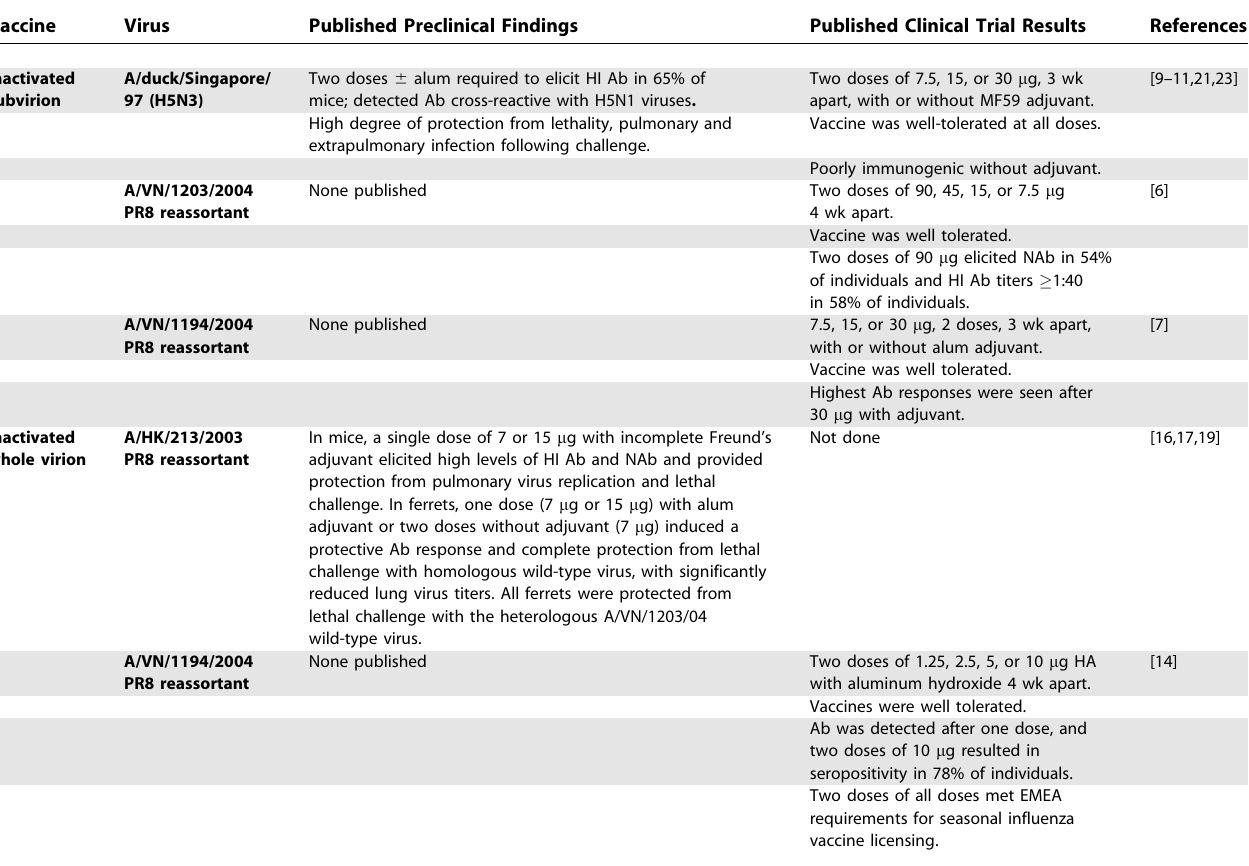
Table 2. Summary of Preclinical and Clinical Findings for Inactivated H5N1 Virus Vaccines Evaluated in